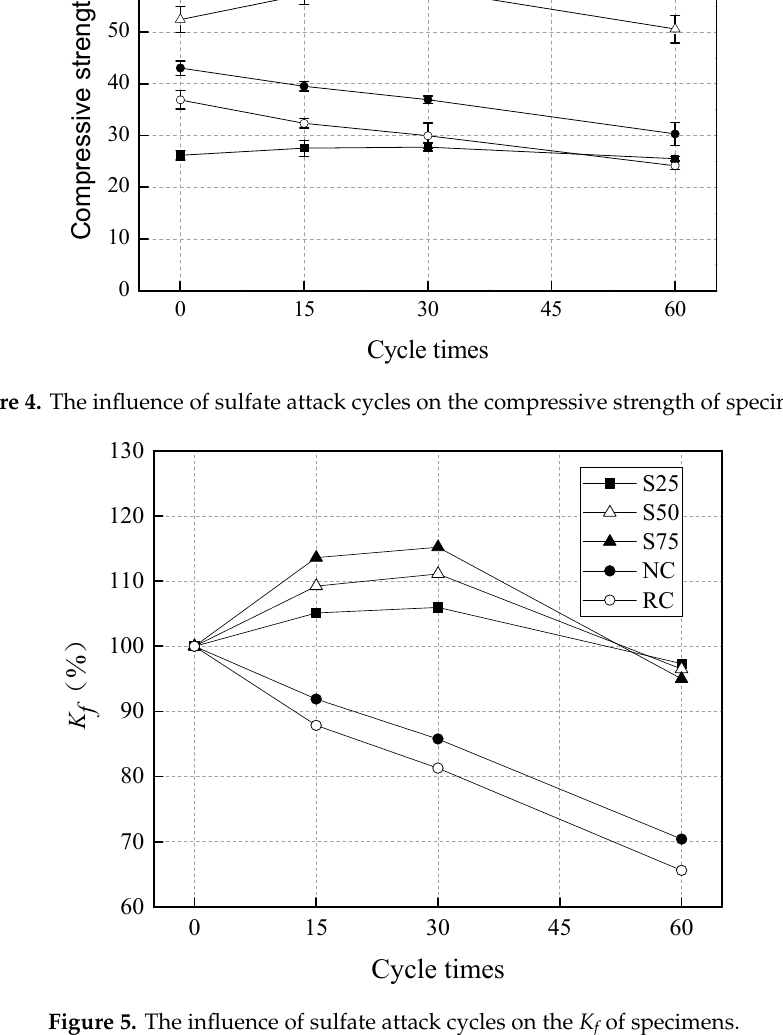
Figure 5. The influence of sulfate attack cycles on the K f of specimens.